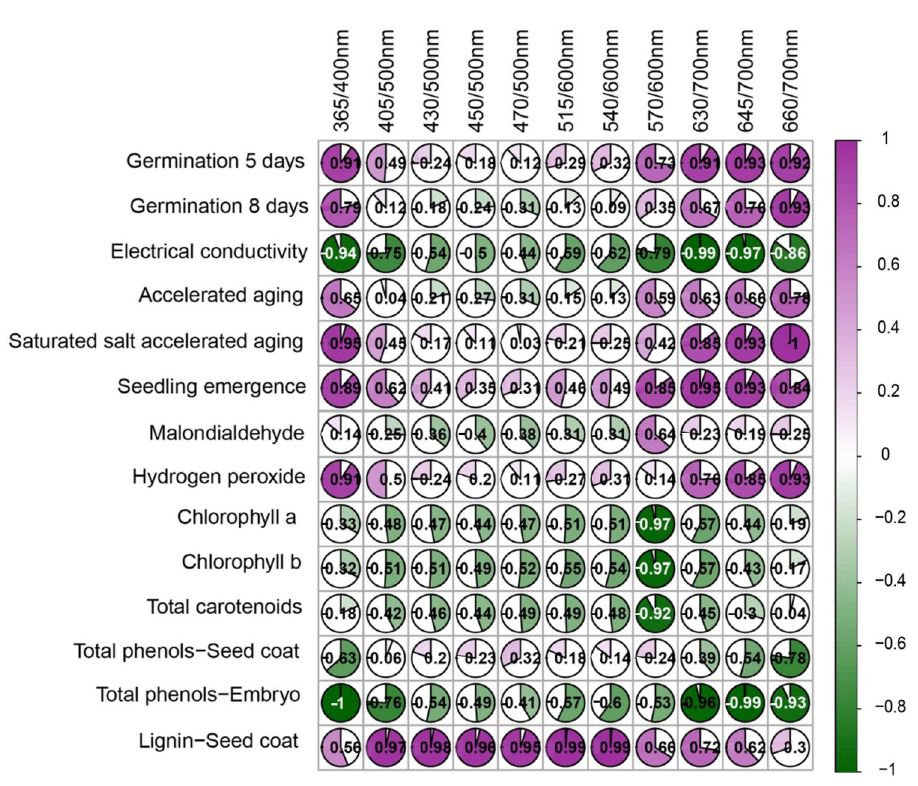
Figure 6. Pearson’s correlation coefficients between autofluorescence-spectral data from different excitation- emission combinations and soybean seed quality